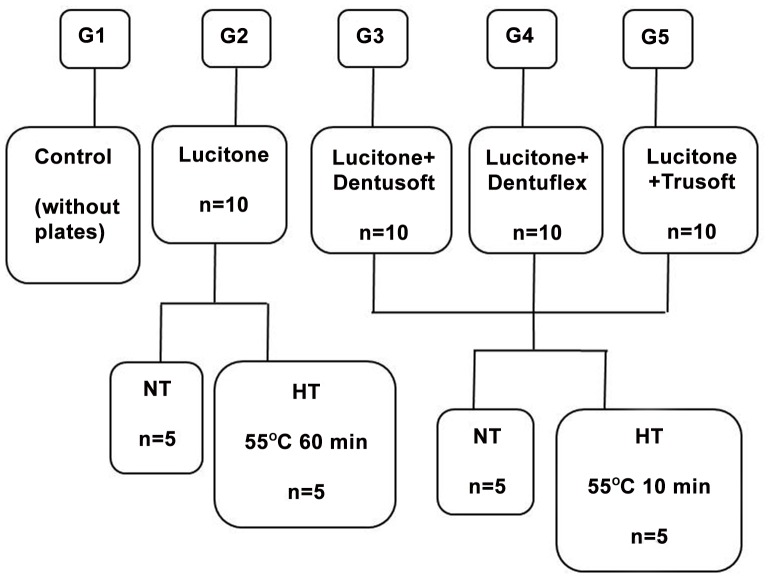
Diagram representation of the experimental groups.NT: no treatment; HT: with heat-treatment.